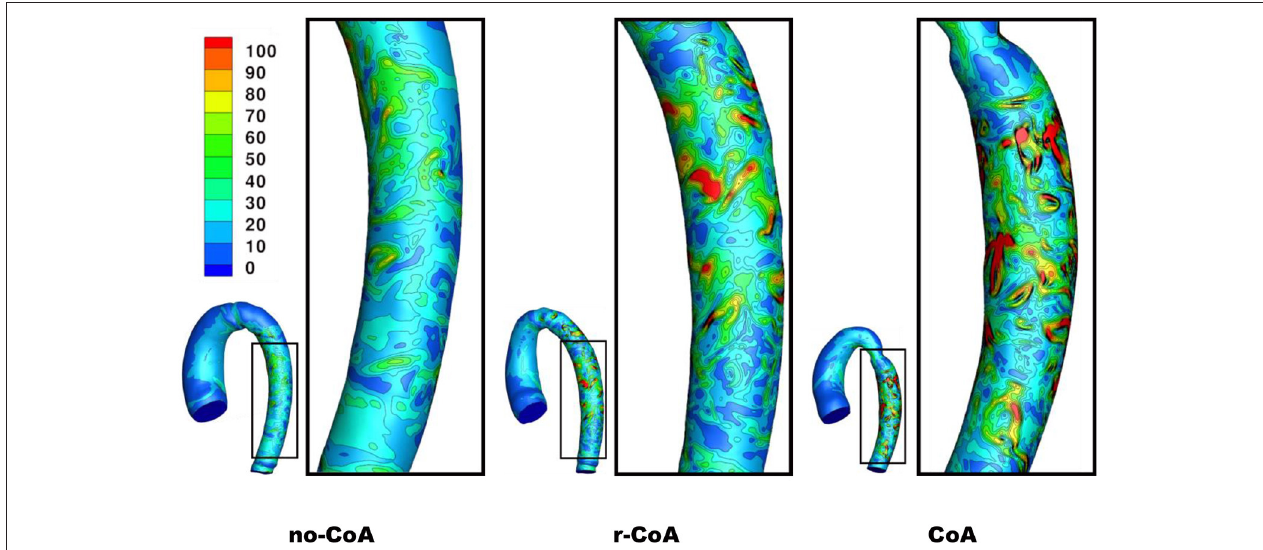
FIGURE 6 | Contour of wall shear stress (WSS) on the descending aorta at end systole.